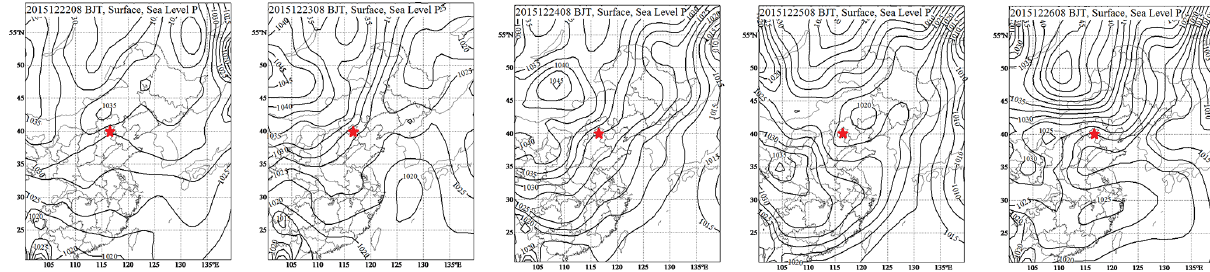
Figure 12. Sea level pressure (hPa) at 08:00CST from 22 to 26 December 2015 (the red five-pointed star represents the Beijing